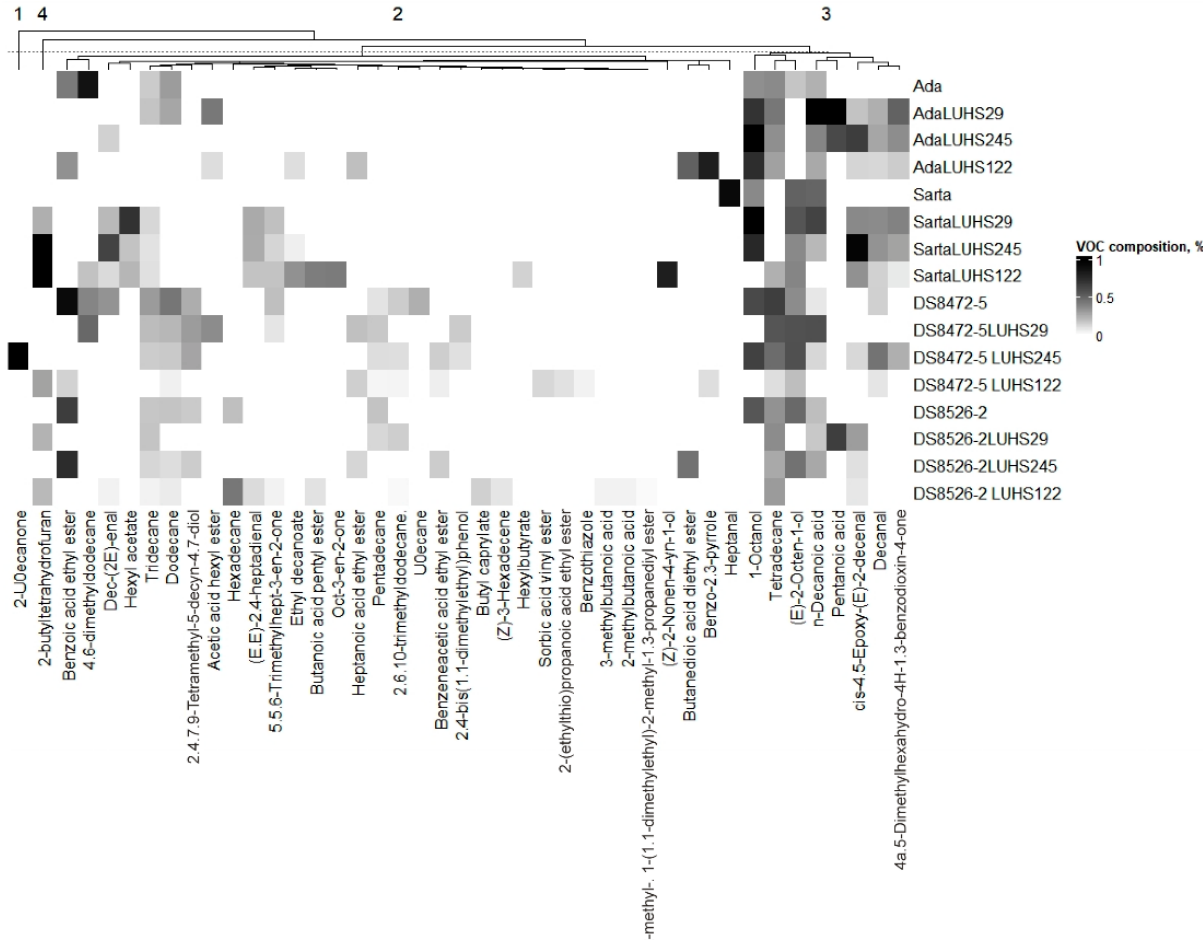
Figure 4. Volatile compounds that are >1% and <5% in at least one wheat wholemeal sample (LUHS29—fermented with Pediococcus acidilactici LUHS29 strain; LUHS245—fermented with Liquorilactobacillus uvarum LUHS245 strain; LUHS122—fermented with Lactiplantibacillus plantarum LUHS122 strain. Data are represented as means ( n = 3)).